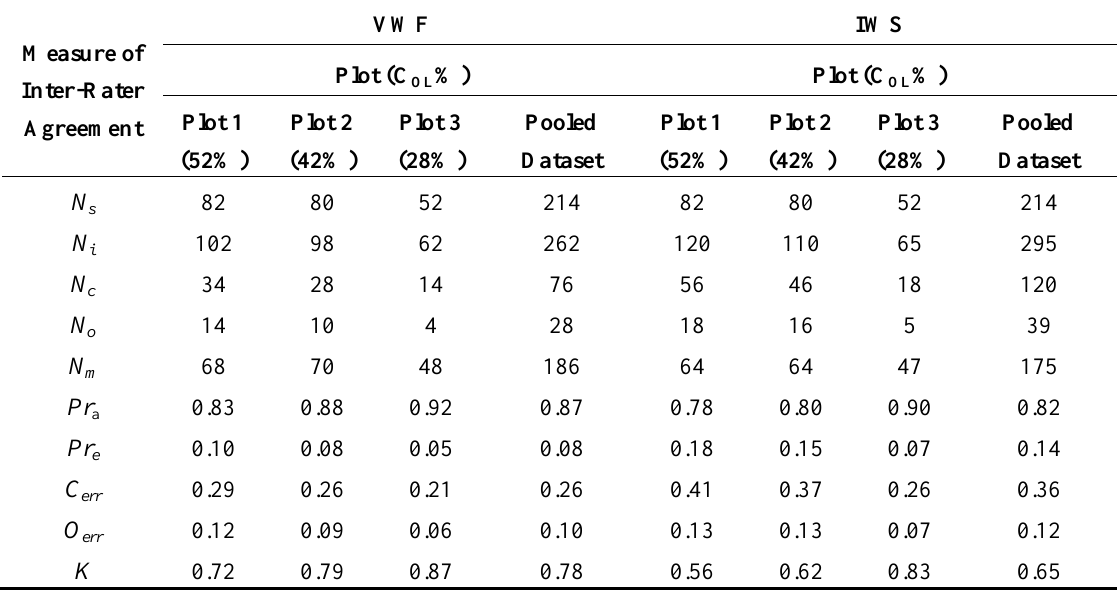
Table 5. Performances of the VWF and IWS methods in extracting the trees from LiDAR data. Measure